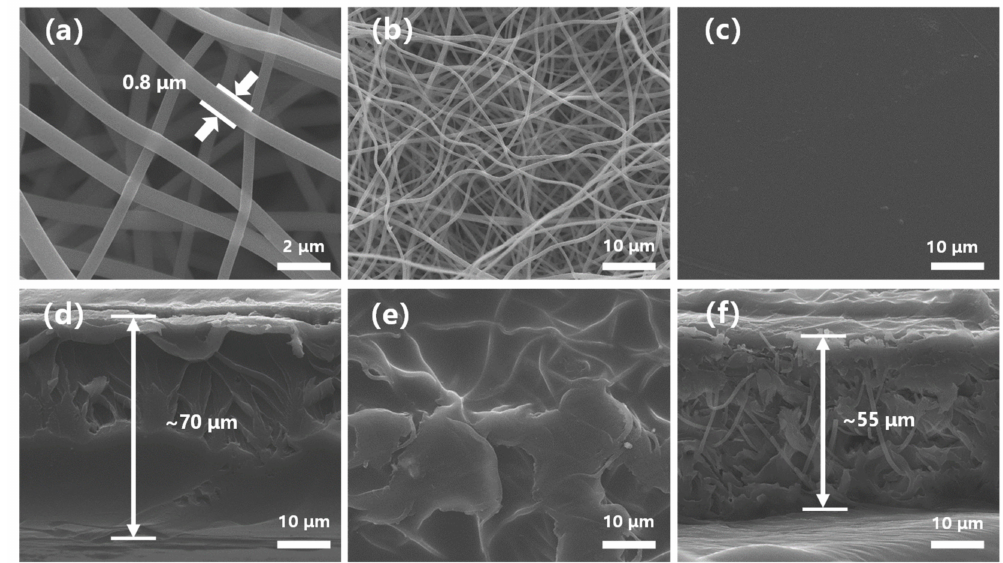
Figure 2. Scanning electron microscope (SEM) images of ( a , b ) polyimide (PI) nanofiber, ( c , d ) SPFEK, and ( e , f ) PI@SPFEK for top surfaces and cross-sections, respectively.